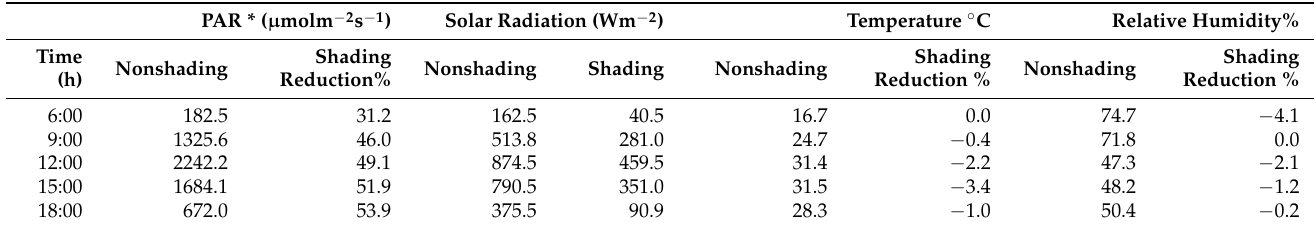
Table 1. Influence of shading on growing environment (average day in July).